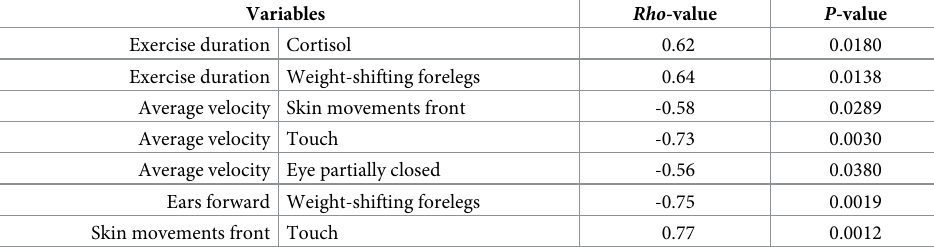
Table 6. Significant Spearman rank coefficients of correlation between the workload variables (exercise duration and average velocity), and the pre- and post-workday differences in facial expression (ears forward), other behav- iours (weight-shifting forelegs and touch), and physiological variable (cortisol) of 14 ranch